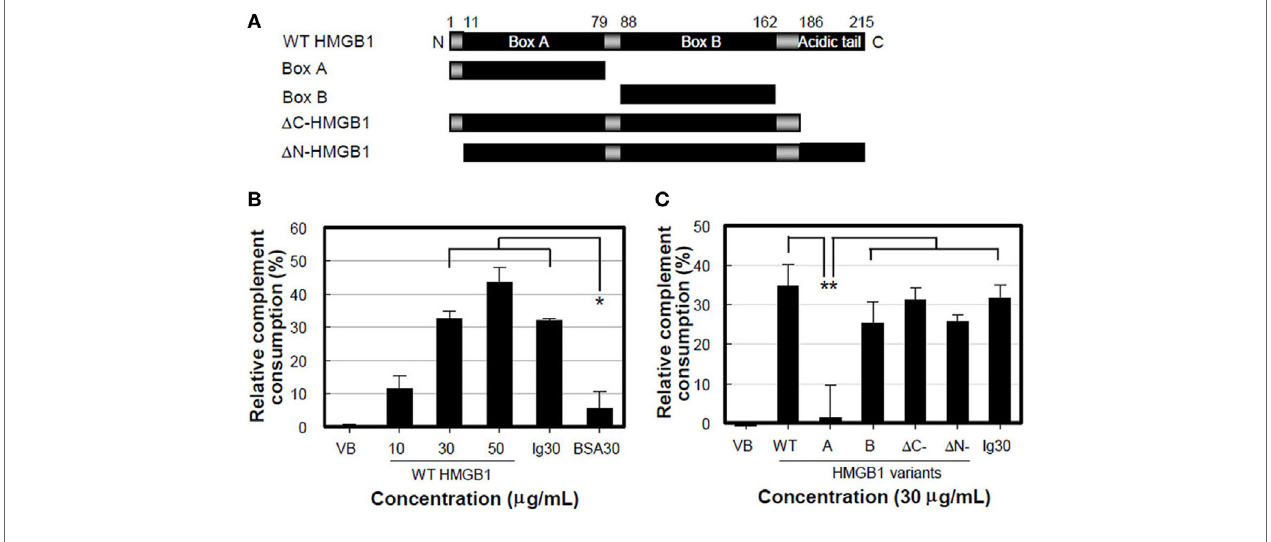
FigUre 3 | High-mobility group box 1 (HMGB1) B box activates complement cascade. (a) Schematic overview of recombinant HMGB1 proteins used: wild-type (WT) HMGB1, boxes A (aa 1-79) and B (aa 88-162), Δ C-HMGB1 (aa 1-185), and Δ N-HMGB1 (aa 11-215). (B,c) Complement consumption assessment. WT HMGB1 proteins (B) or HMGB1 variants (c) were incubated with the diluted normal human serum (NHS) containing CH 50 activity in GVB 2 + buffer for 30 min at 37°C. After complement consumption by HMGB1, sRBCs were added in the consumed NHS for 30 min at 37°C. Aggregated human IgG and IgG-free BSA (each 30 µg/ml) were used as the positive and negative controls, respectively. Data shown are the mean ± SD of three independent repeats. * P < 0.01 vs. BSA30, ** P < 0.001 by two-way ANOVA with Bonferroni correction.